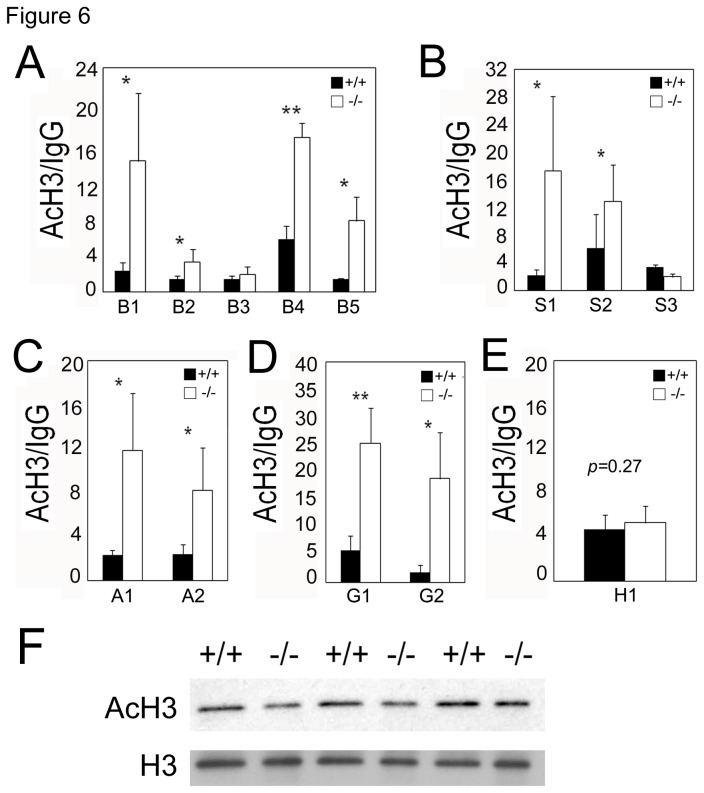
ChIP-qPCR assays of AcH3 enrichment at β-MHC (A), Sfrp2 (B), Acta1 (C), Grk5 (D) and Hoxb5 (E) loci in wild-type and Asxl2
-/- hearts.Data from AcH3 ChIP were normalized against those from IgG mock ChIP. Each column represents the mean value of data from three independent samples. *p<0.05; **p<0.01; Error bar: standard deviation. (F) Western blot analysis of bulk AcH3 in three pairs of wild-type and Asxl2
-/- hearts. To control for comparable protein loading, the blot was stripped and re-blotted for histone H3.